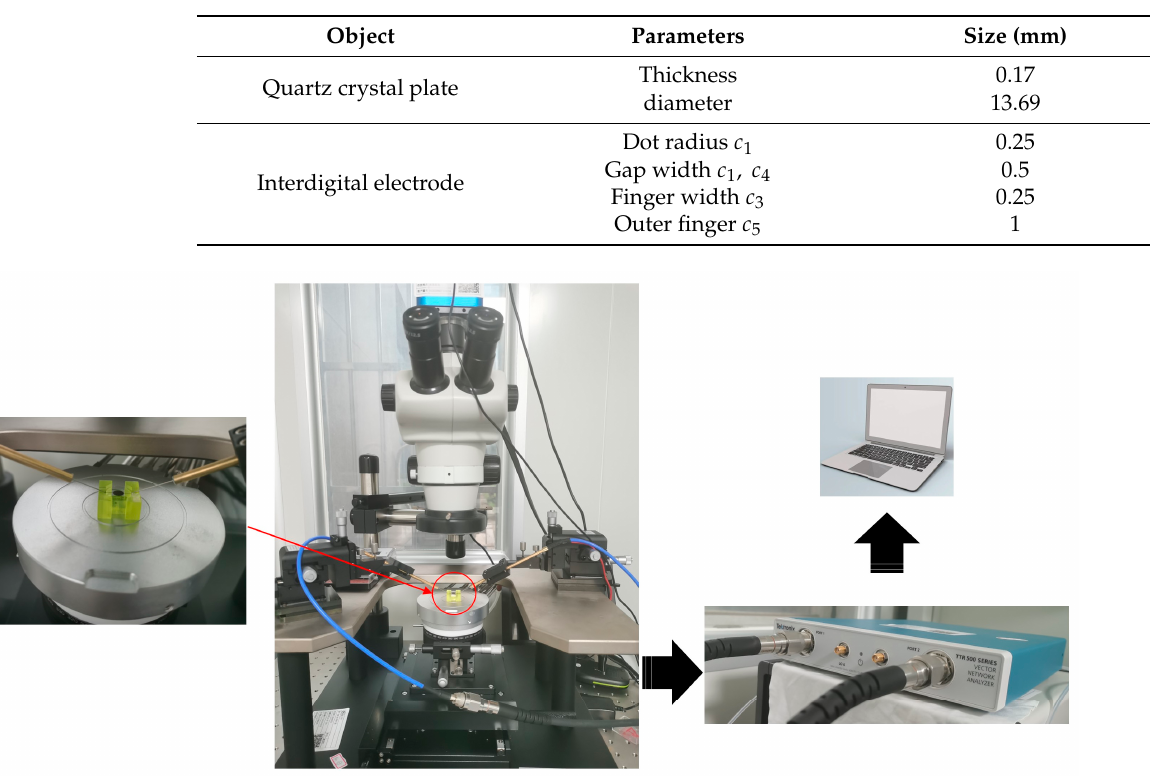
Figure 10. The experiment flow chart of the QCM with interdigital electrode.